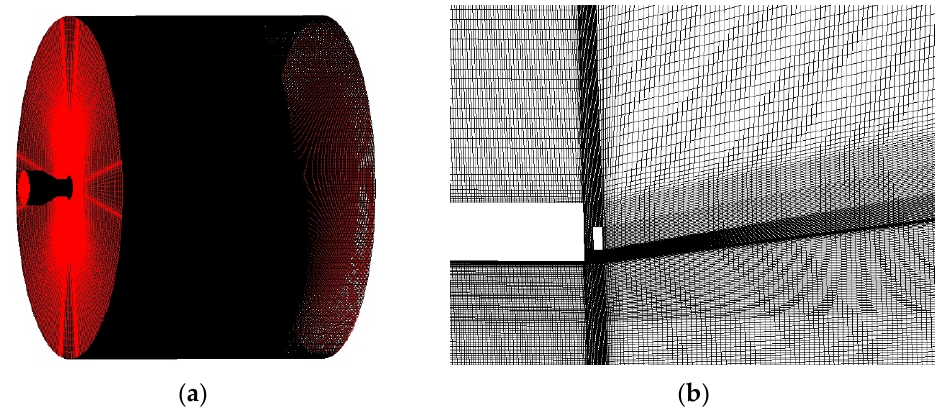
Figure 2. Computational mesh of ( a ) the overall domain and ( b ) the axial near the nozzle exit.